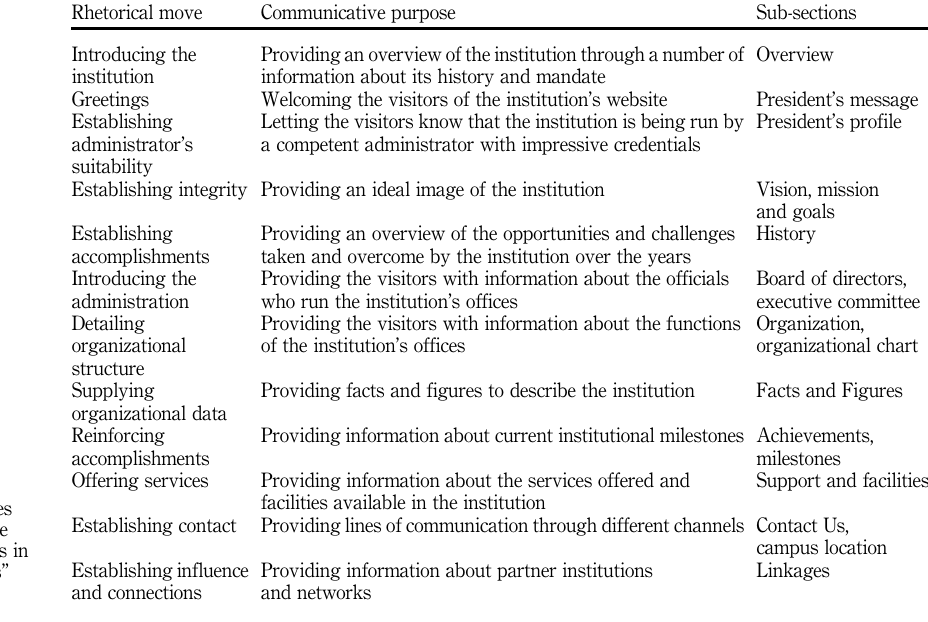
Table II. Rhetorical moves employed by the AAOU members in their “ About Us ”